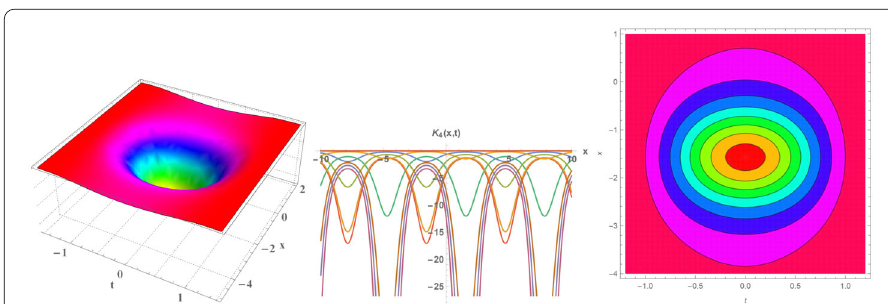
Figure 2 Numerical simulation of Eq. (14) in three distinct types of plots